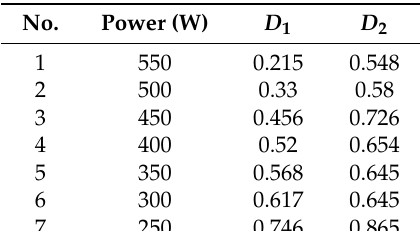
Table 2. Optimization results.